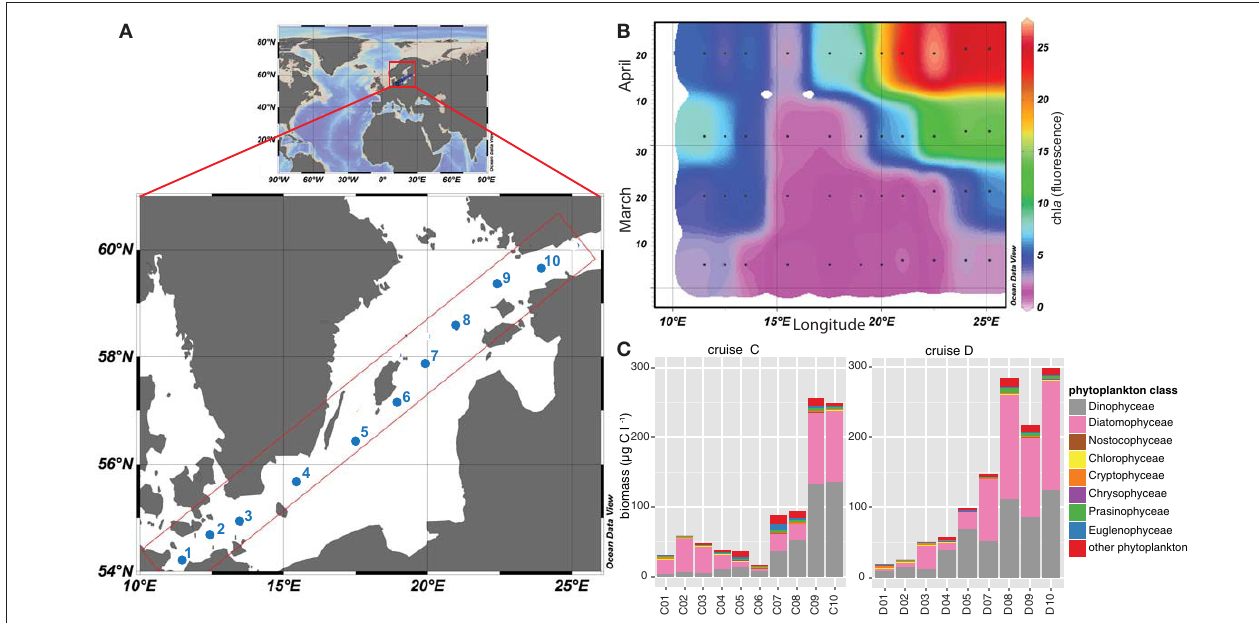
FIGURE 1 | Map of the Baltic Sea illustrating the sampling stations included in this study. (A) The map demonstrates the Baltic Sea, within Europe, and the sampling transect over the Baltic Proper. Sampling stations during the four cruises (A–D) are labeled from 1 to 10, ranging from stations 1-3 in the southern and stations 8–10 in the northern coastal part of the Baltic Proper. Stations 4-7 were located in the open Baltic Proper. (B) Relative chl a fluorescence [measured with the flow through system on board and modified from Godhe et al. (2016)] across the transects over the Baltic Proper from March to April 2013 (cruise A–D). Black dots describe sampling occasions, values were extrapolated using Ocean Data View. (C) Phytoplankton biomass in µ g C l − 1 during cruise C (early April) and D (late April) along the transect, based on microscopy